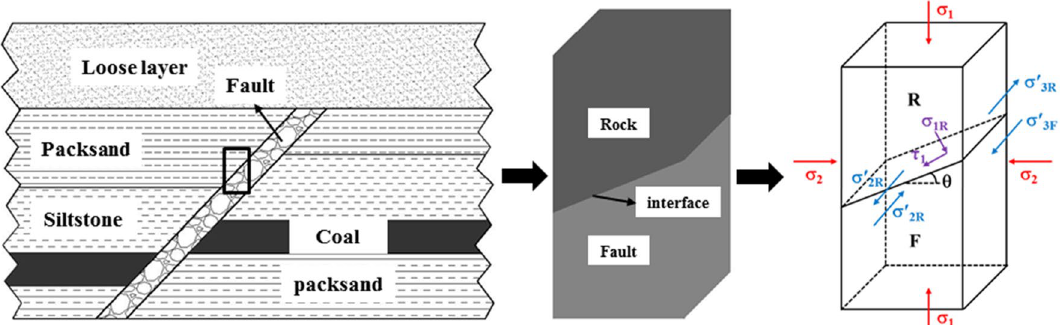
Figure 1. Force diagram of mechanical model. (R: Rock mass; F: Fault zone; σ 1 : Axial force on the structure; θ : Fault dip angle; σ 1 R and τ 1 : Two component forces of σ 1 on the contact surface, σ ′ 2 R and σ ′ 2 F : Rock mass and binding force of the fault zone in the second direction at the contact surface; σ ′ 3 R and σ ′ 3 F : Binding force of the rock mass and the fault zone at the contact surface in the third